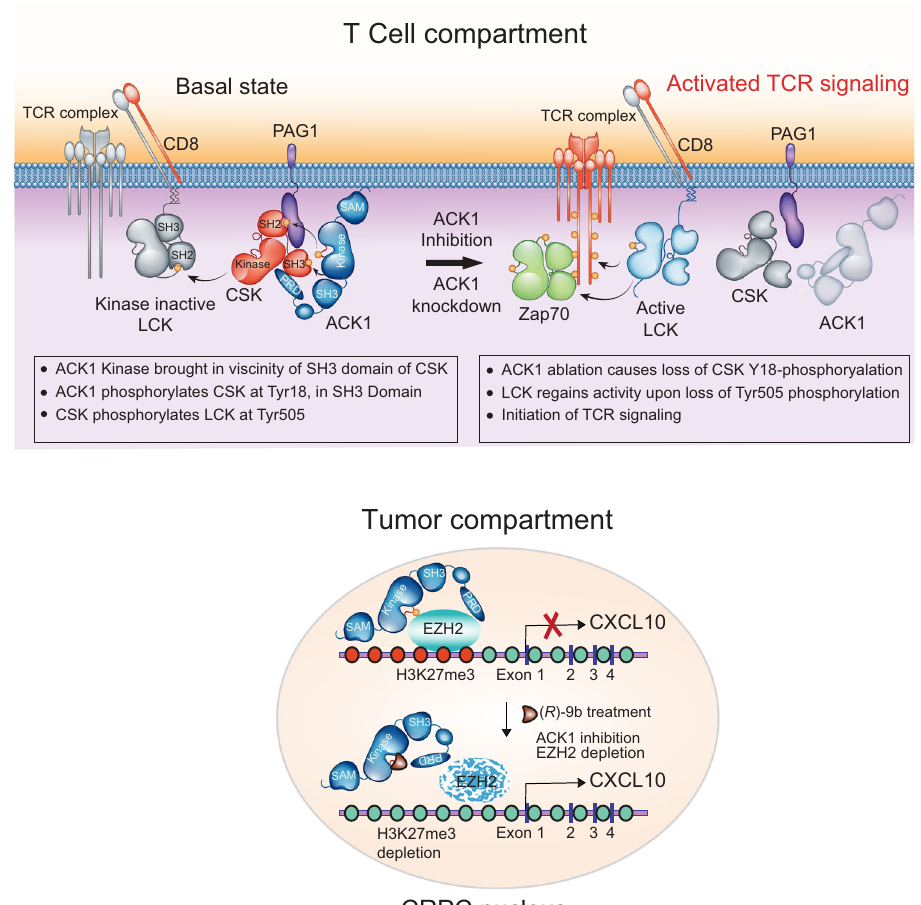
Fig. 8 | A model for role of ACK1 in T cell activation and corresponding para- crine signaling in tumors, a graphical representation. PAG Tyr317- phosphorylation brings SH2 domain of CSK kinase in proximity of PAG and ACK1, whichphosphorylatesCSKatTyr18inSH3domain.Theproline-richregionofACK1 (PRD) interacting with SH3 domain of CSK could further stabilize the ACK1-CSK interaction. pY18-CSK phosphorylates LCK at Tyr505, preventing ligand- independentTCRactivation.GeneticablationoritsinhibitionofACK1by( R )- 9b not only prevented CSK Y18-phosphorylation and LCK Y505-phosphorylation, but also